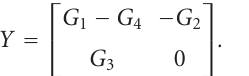
Figure 4: (a) Realization of Figure 3(a) using two CCII+ and one CCII − [16]. (b) Realization of Figure 3(b) using two ICCII − and one CCII −